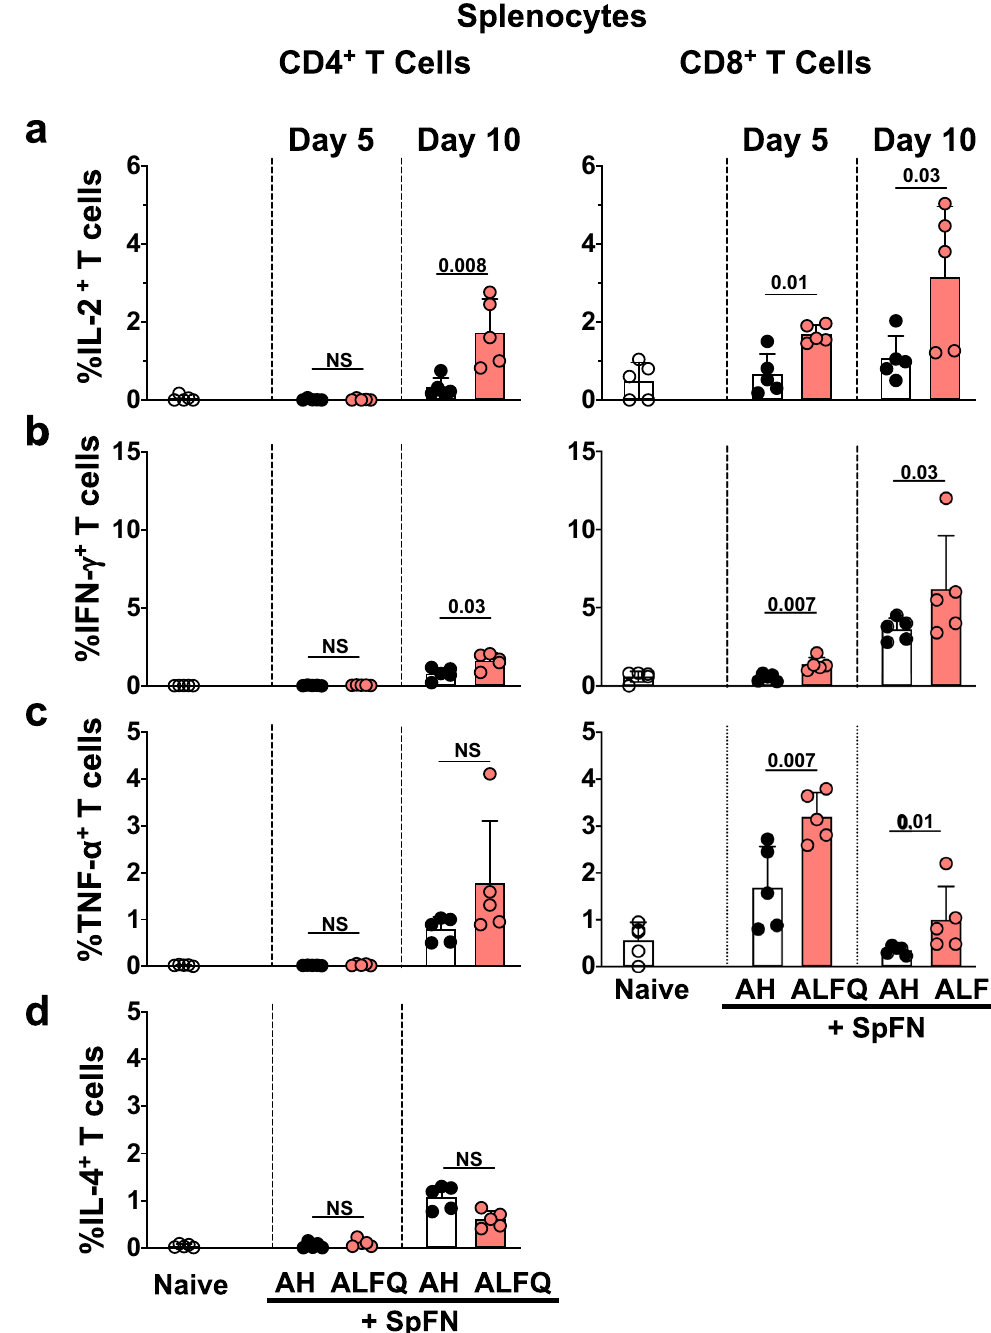
Fig. 3 Splenic T cell responses in mice vaccinated with SpFN vaccine. a – c Flow cytometry-based characterization of mouse splenocytes at days 5 and 10 post-vaccination measuring SARS-CoV-2 spike-speci fi c intracellular cytokine responses in CD4 + and CD8 + T cells a IL-2-, b IFN- γ - c TNF- α -, and d IL-4- secreting T cells. Dots represent data from individual vaccinated or naïve mice ( n = 5/group). Bars represent mean + s.d. Statistical signi fi cance between the groups was determined using a nonparametric Mann – Whitney U -test with p ≤ 0.05 considered as statistically signi fi cant. The gating strategy applied for the evaluation of fl ow cytometry-acquired data presented in this fi gure is provided in Supplementary Fig.